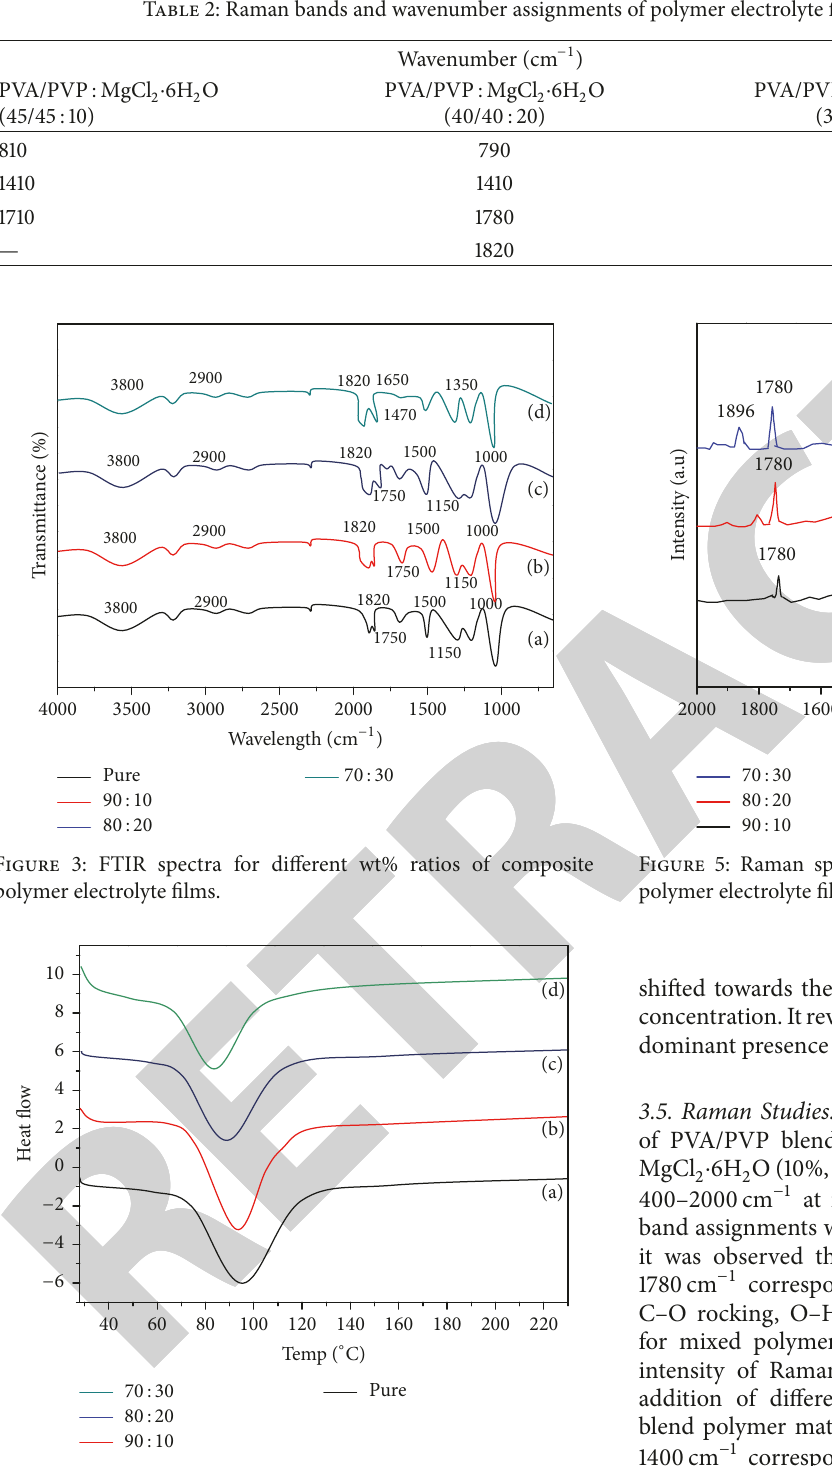
Figure4:DSCspectrafordifferentwt%ratiosofcompositepolymer electrolyte films.